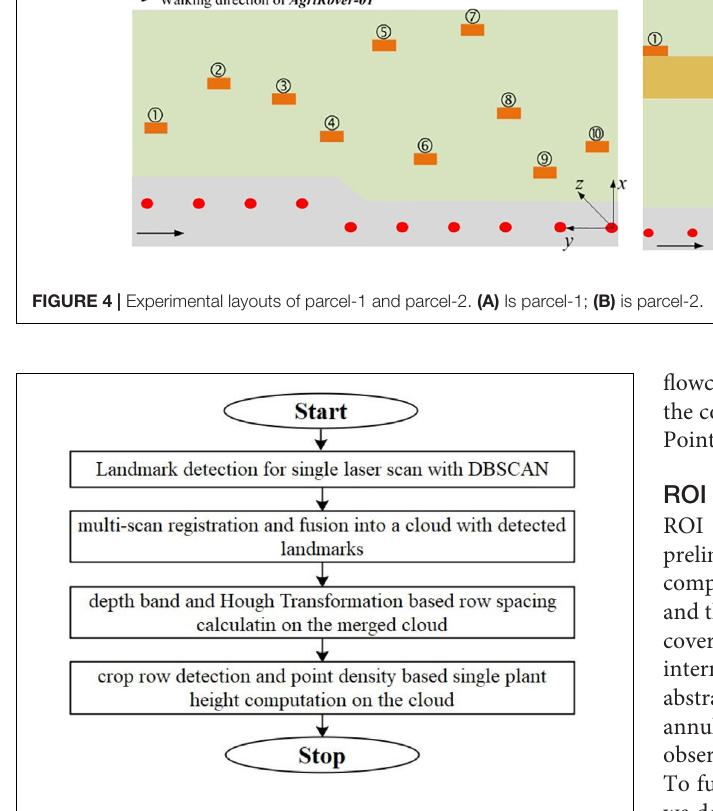
FIGURE 5 | Flowchart for the general framework of data processing.